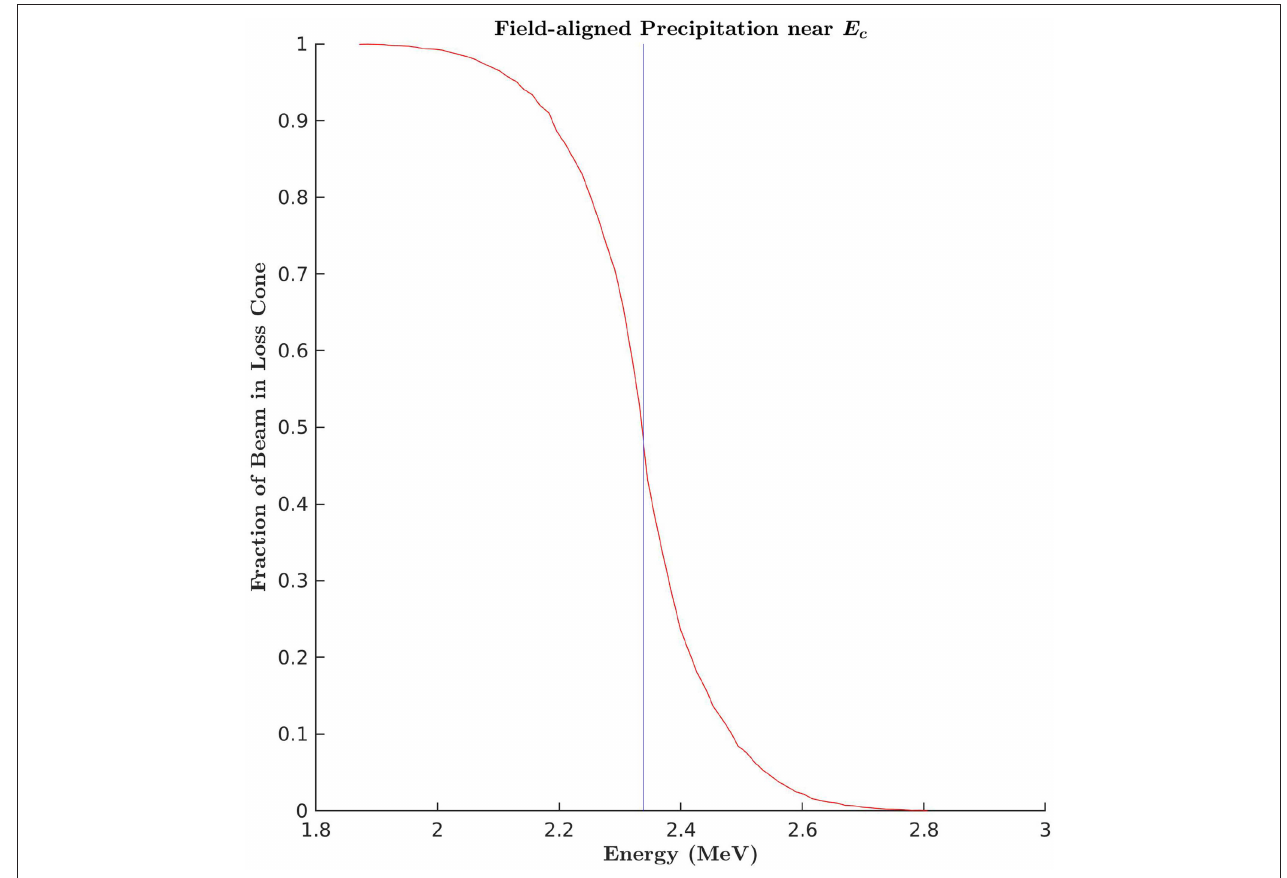
1/ 3. E c is 0.005, σ = =